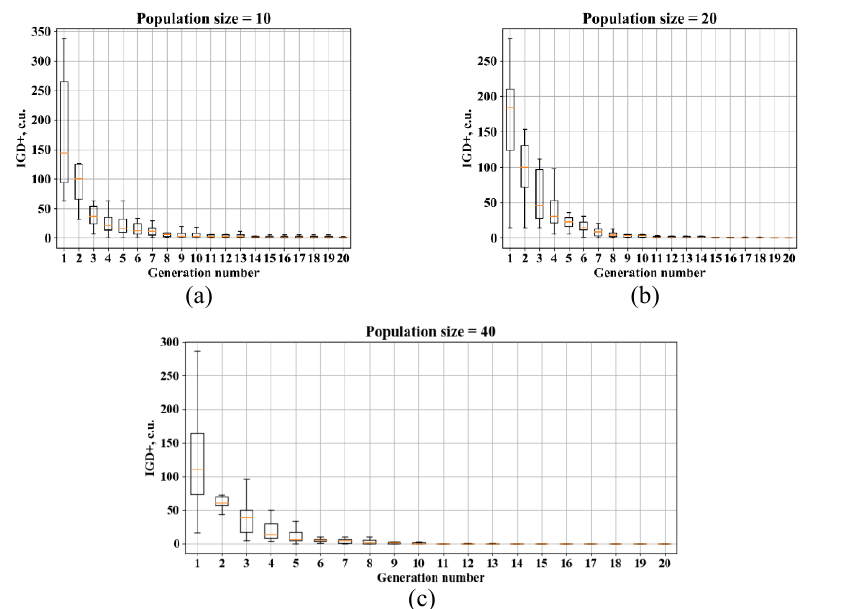
Fig. 10 . Convergence of NSGA II with UX and population size of 10 (a), 20 (b),